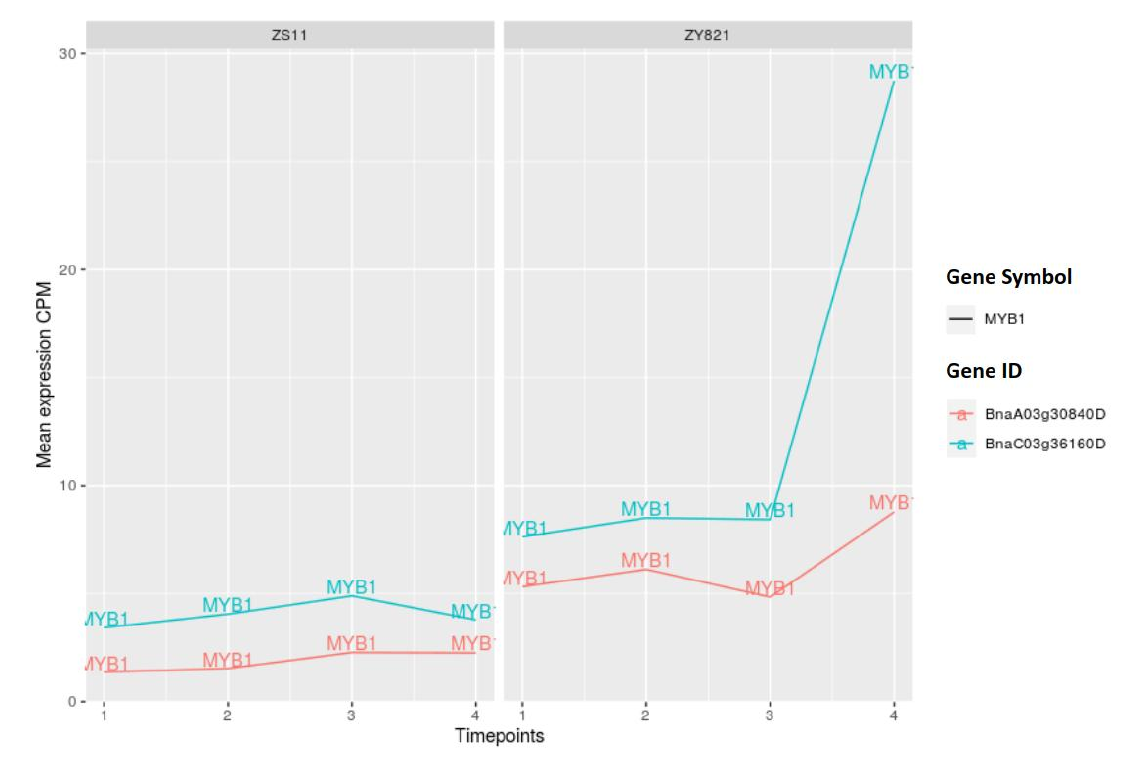
Figure 9. Expression values of MYB1 orthologous genes. Time points 1 to 4 represents day 7, day 10, day 15, and day 45 after flowering.